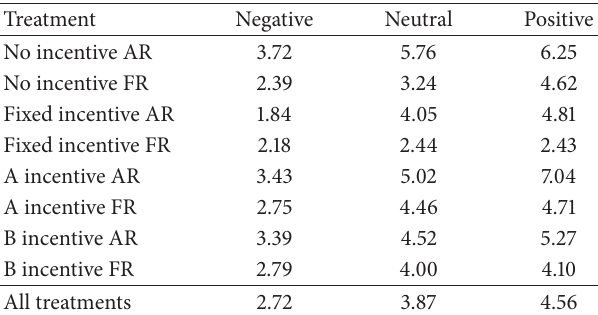
Table 4: Average investments by treatment and rating.